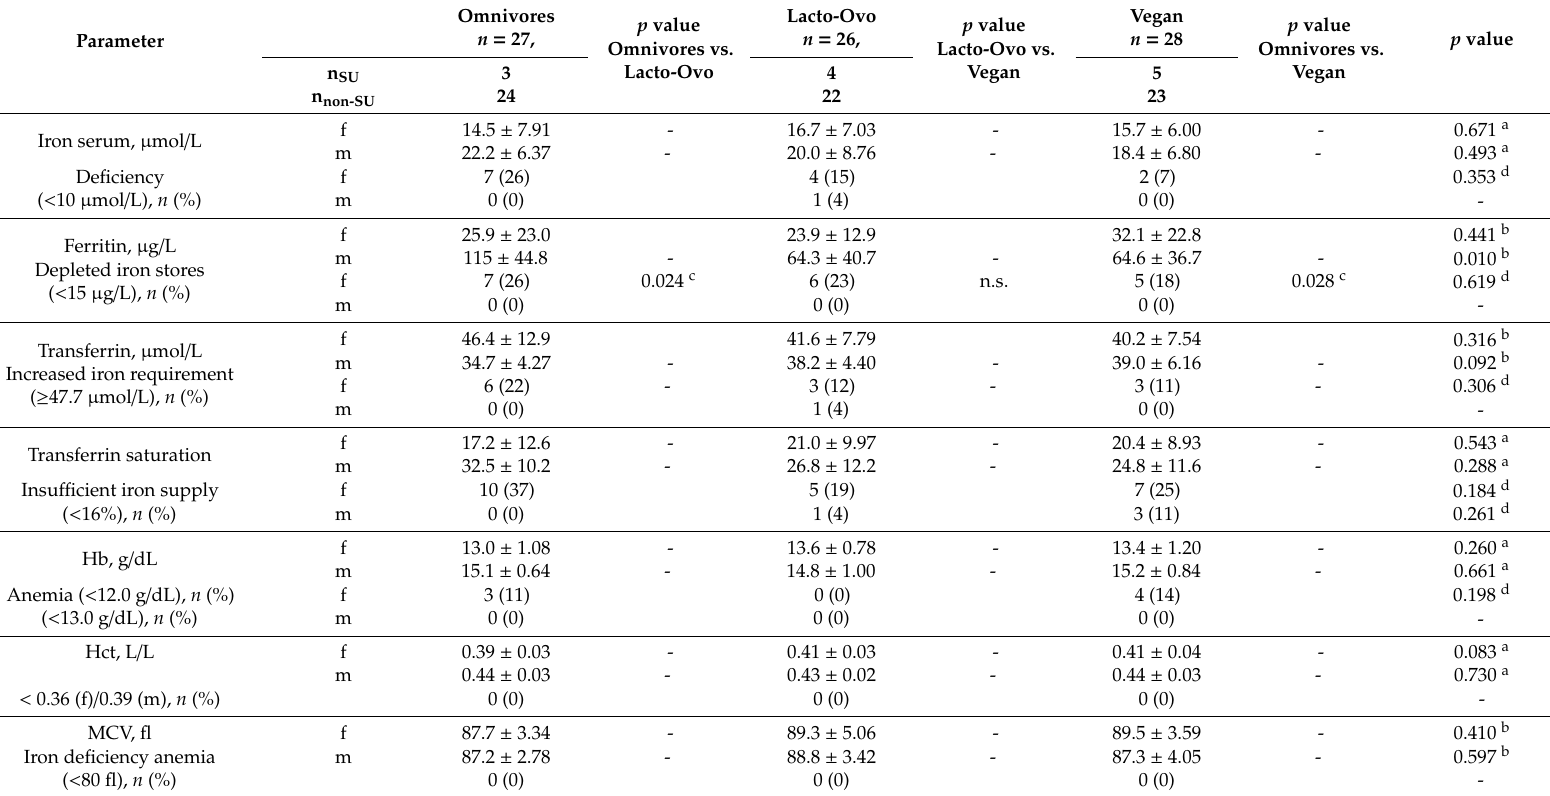
Table 4. Biomarkers of iron status and hematological